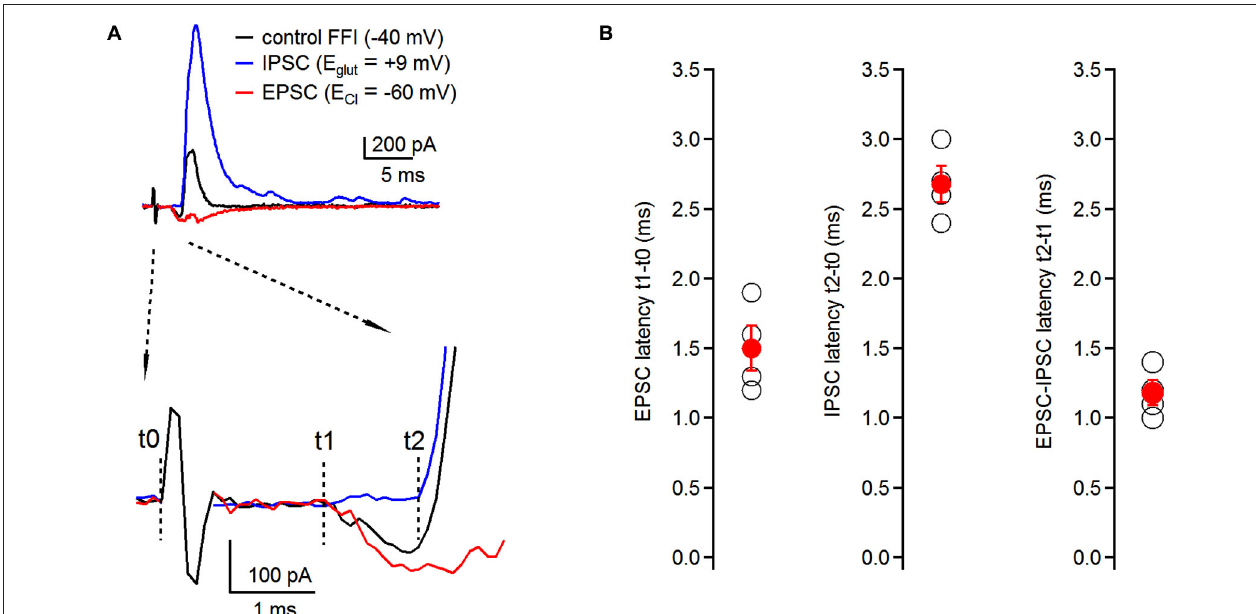
and the onset of synaptic events (t1 for EPSCs, t2 for IPSCs). EPSC-IPSC latency was calculated as t2 − t1 (bottom traces). Traces represent averages of 5–10 trials. Only stimulation artifact in the control FFI (black) trace is shown, the other two were removed from EPSC and IPSC traces for clarity. (B) Plots of latencies of EPSCs and IPSCs from the stimulation artifact, and timing of EPSC-IPSC sequence. Each black data point represents one neuron; red data points represent averages ± SEM; n = 4